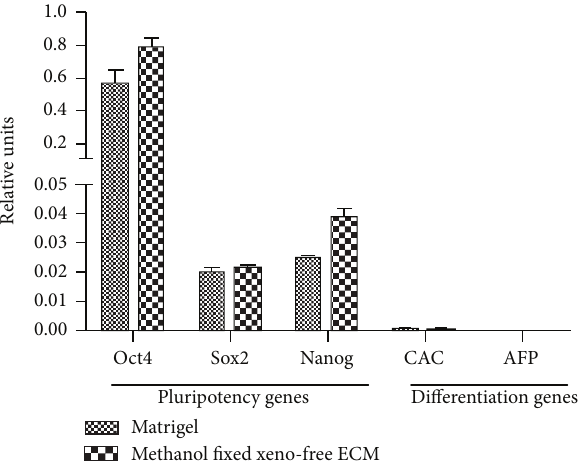
Figure 6: Quantitative PCR analysis of pluripotent gene expression in hESCs maintained for 25 passages on Matrigel or methanol fixed xeno-free ECM.